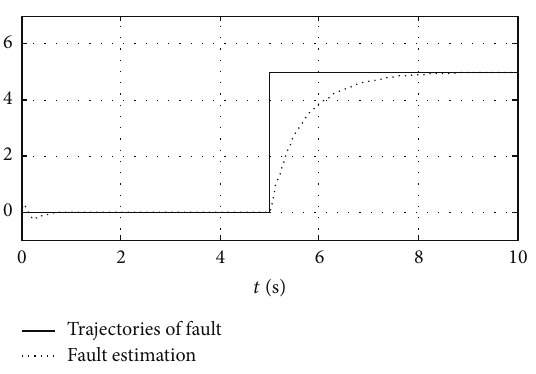
Figure 3: The original signal from transmitter.